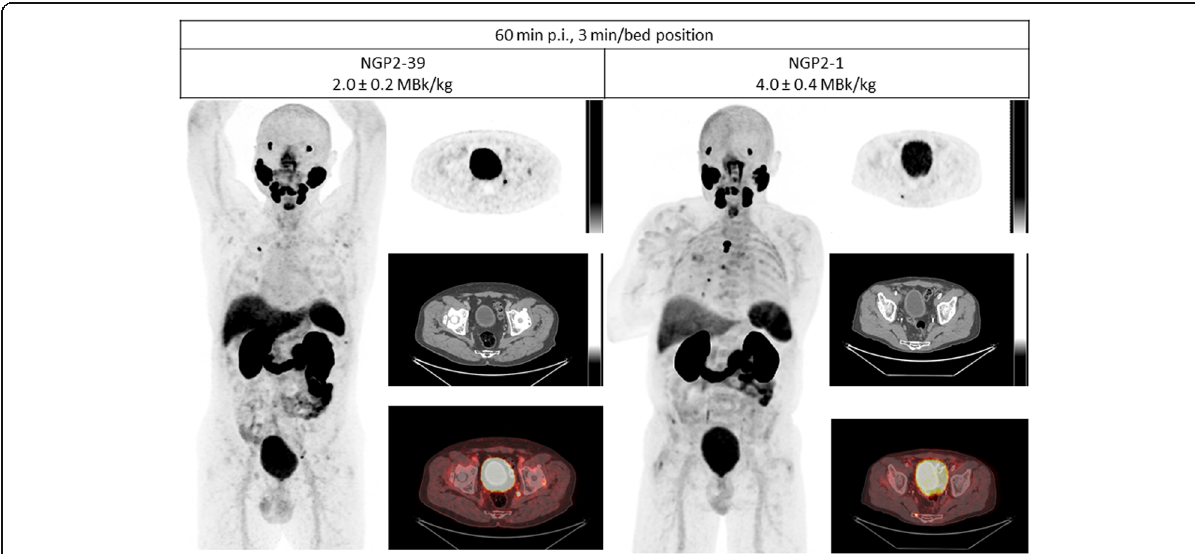
Fig. 2 Comparison of images at T60, 3 min/bed position of two patients NGP2-39 and NGP2-1 who received 2 and 4 MBq/kg, respectively.